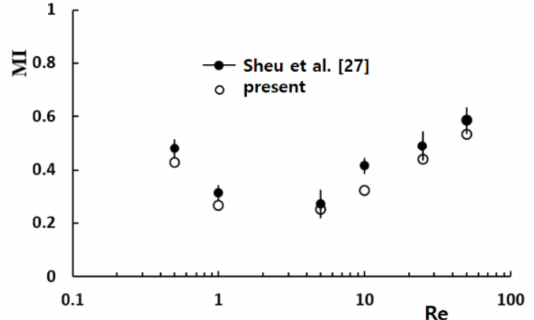
Figure 6. Validation of the numerical approach [27].